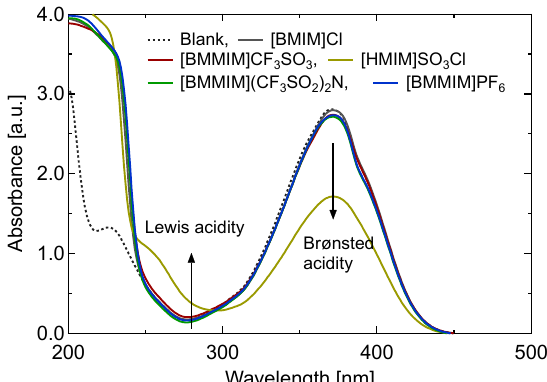
Figure 7. UV-visible spectra of p -nitroaniline in methanol containing IL at 80